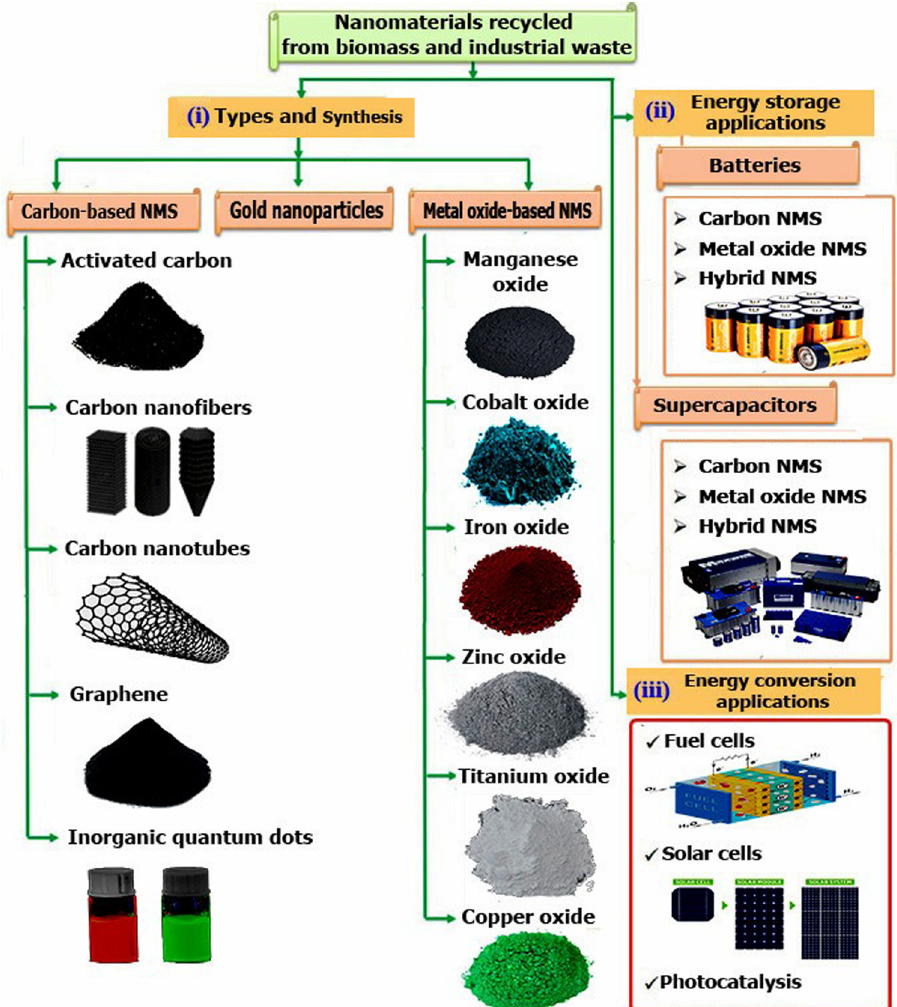
Figure 6: Classi fi cation of nanomaterials from